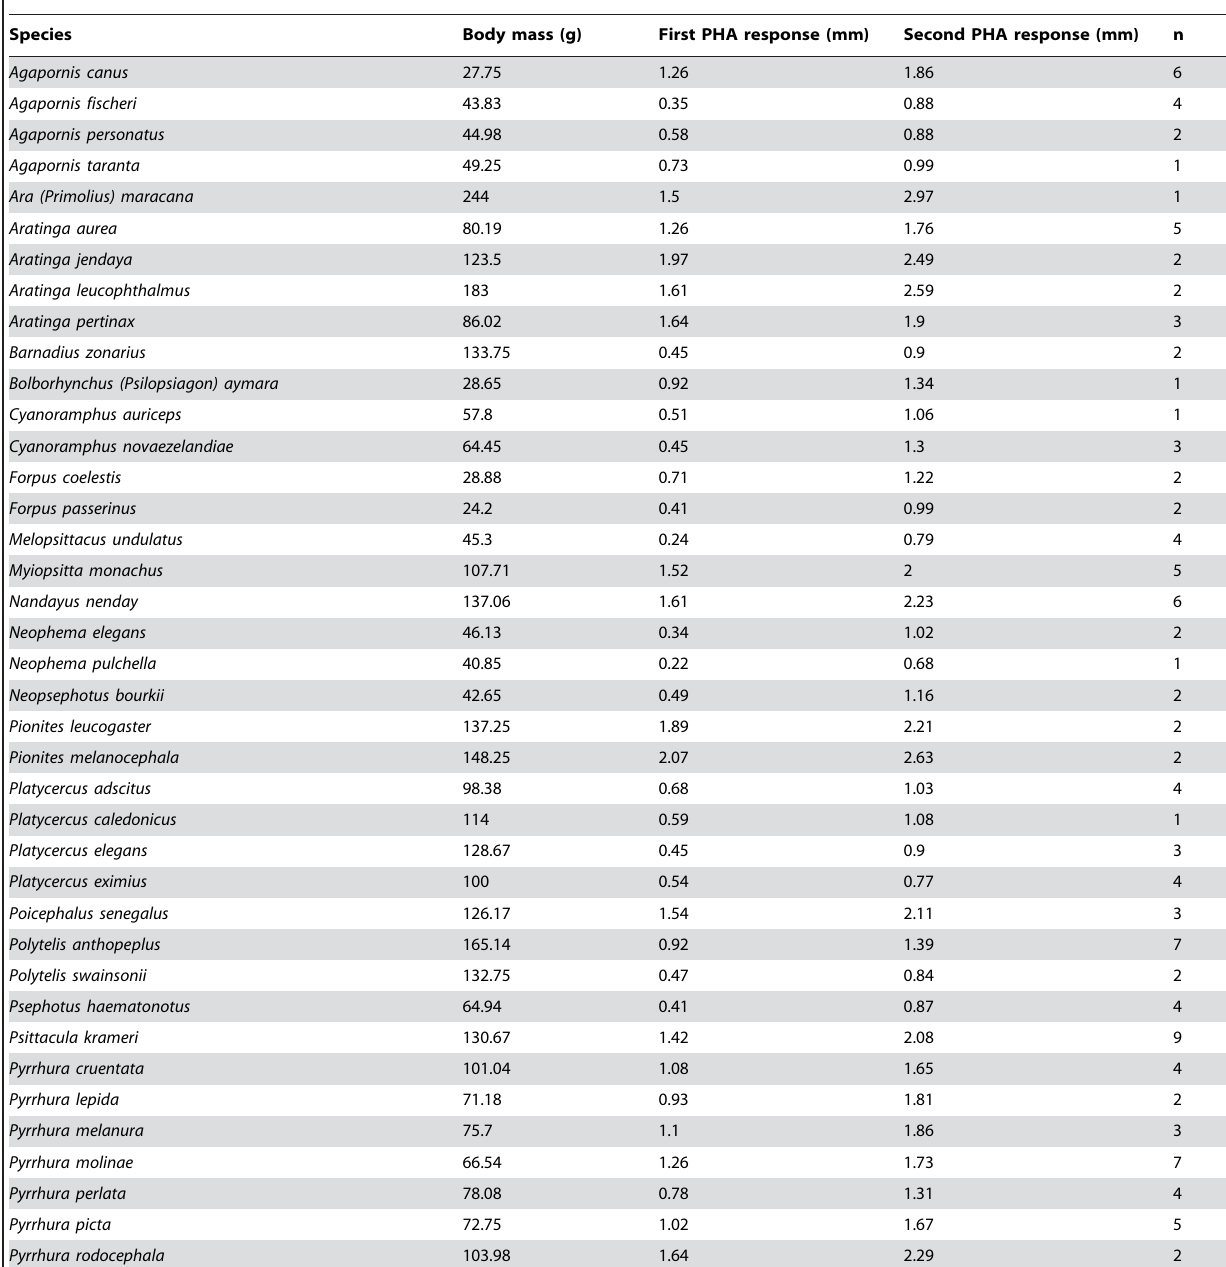
Table 1. Species and number of individuals used for assessing two consecutive responses to PHA injection.